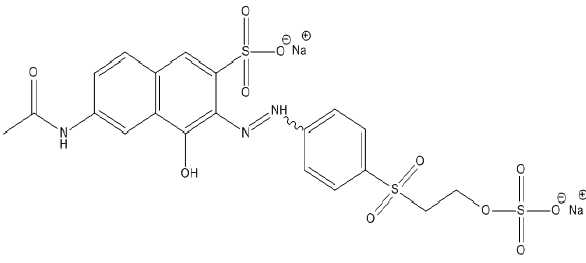
Figure 2. Chemical structure of Reactive Orange 16.